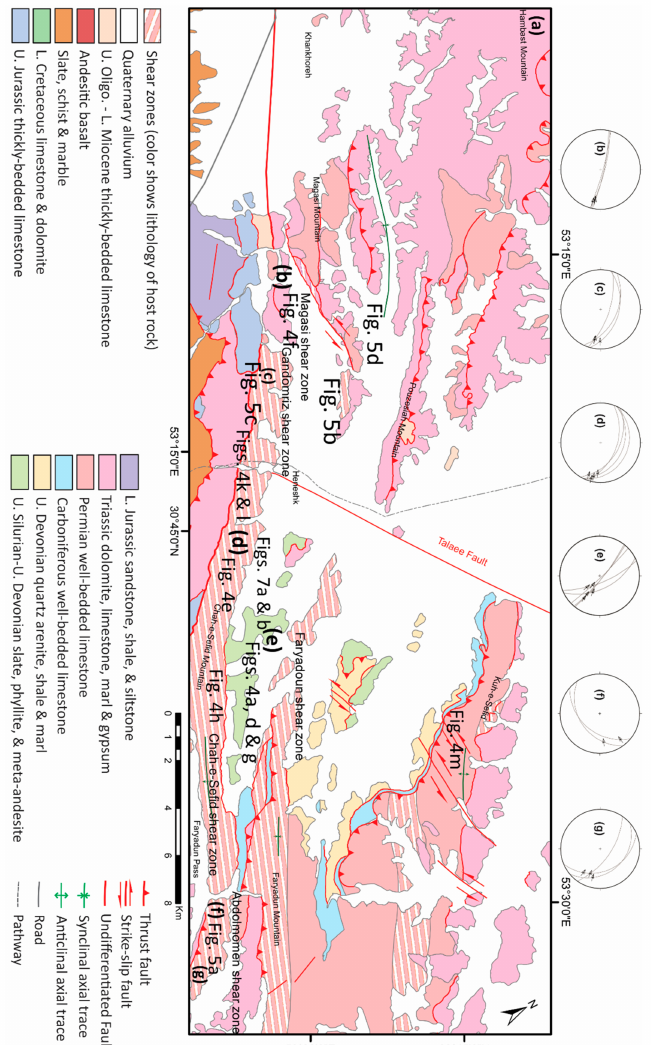
Figure 3. ( a ) Geological map of the SE of the study area, modified after [37], ( b – g ) Stereographic projection from the lower hemisphere showing the orientation of the foliations, stretching lineations, and the shear senses of the Magasi ( b ), Gandomriz ( c ), Chah-e-Sefid [43] ( d ), Faryadun [43] ( e ), Abdolmomen 1 ( f ), and Abdolmomen 2 ( g ) shear zones,